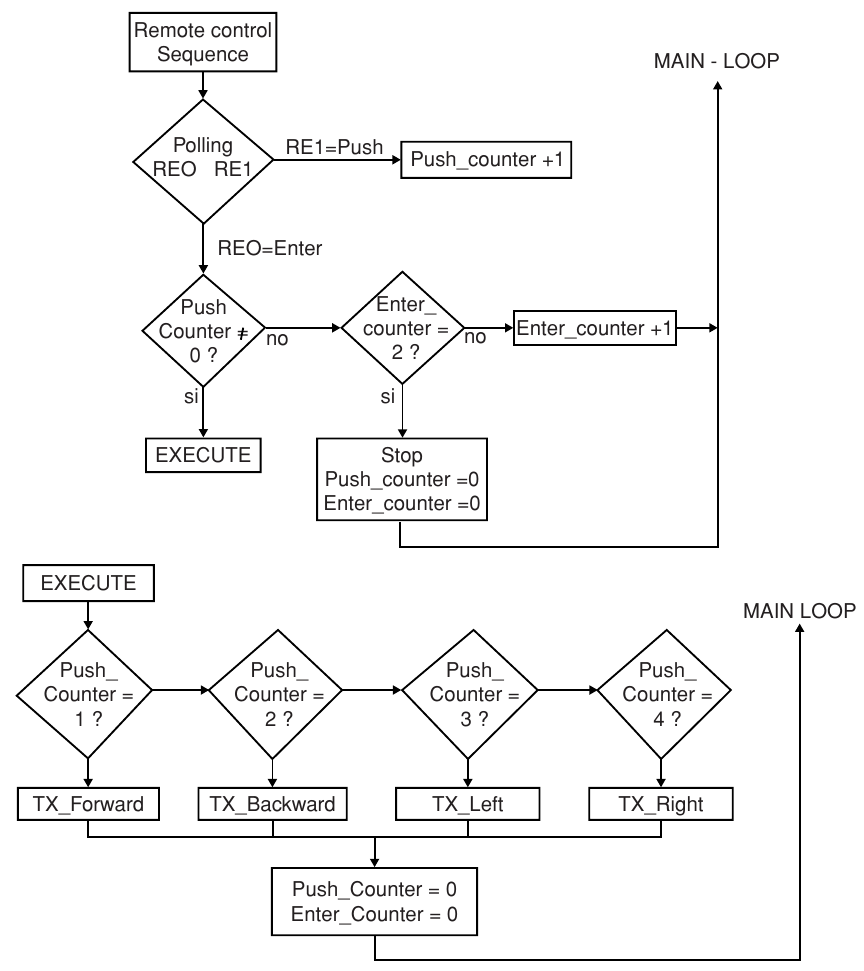
Figure 5 The subroutine in charge of analyzing the action sent by the operator and the subroutine in charge of sending the information to the